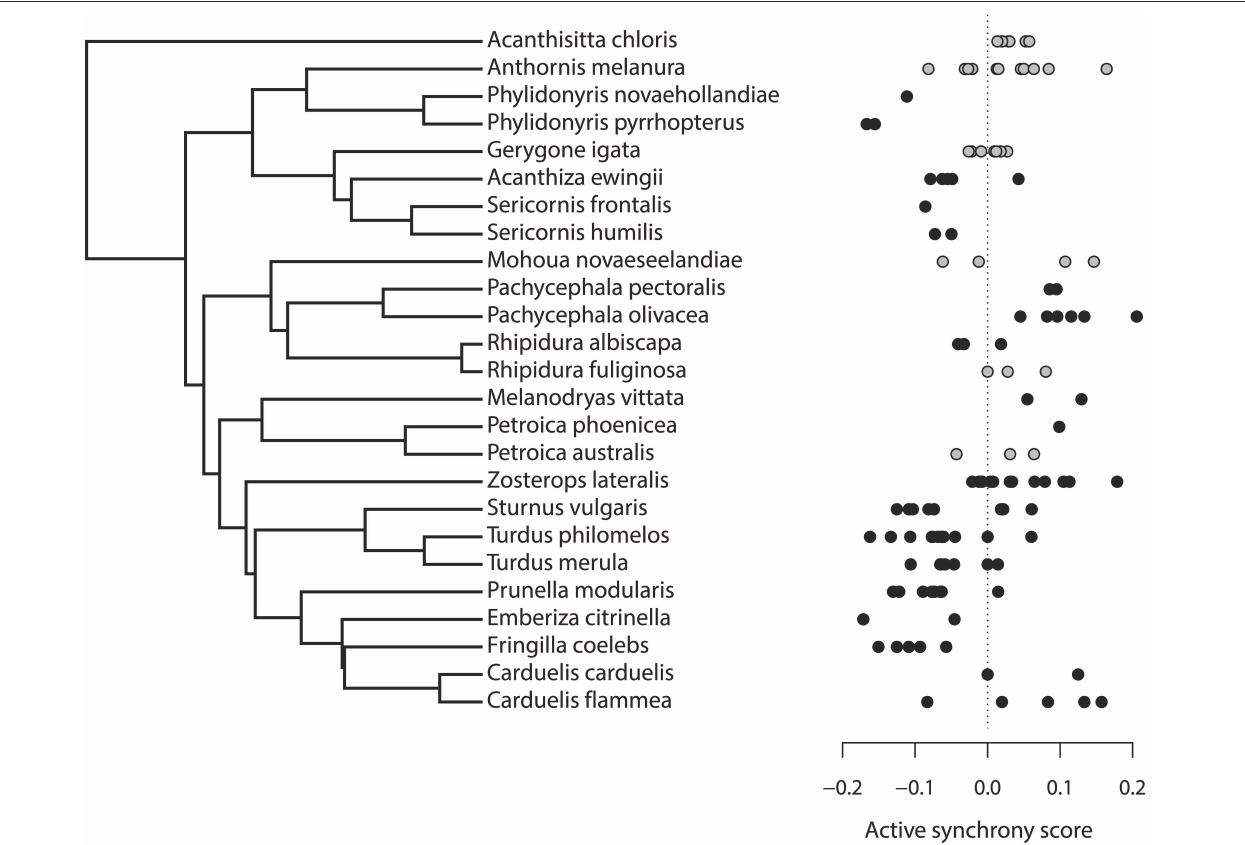
FIGURE 1 | Phylogeny showing relationships between the 25 species used in our comparative analysis, with branch lengths from 1 of 1,300 sample trees downloaded from BirdTree.org (Jetz et al., 2012). Points show an active synchrony score for each nest watch; this is the observed proportion of visits that occurred within 120s of the previous, minus the median (“expected”) proportion from 100 simulated nest watches with the same visit rate. Points are grey for New Zealand species and black for Tasmanian and introduced European